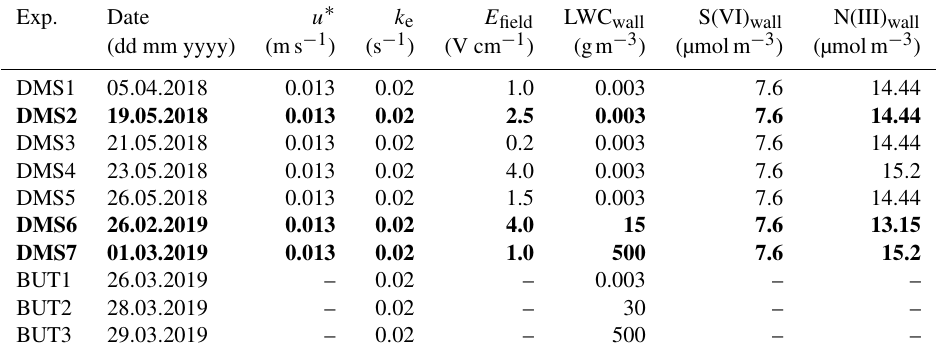
Table 2. Default model setup. Experiments DMS2, DMS6 and DMS7 marked in bold are referred to as “dry”, “humid” and “cold” in Sect. 3.